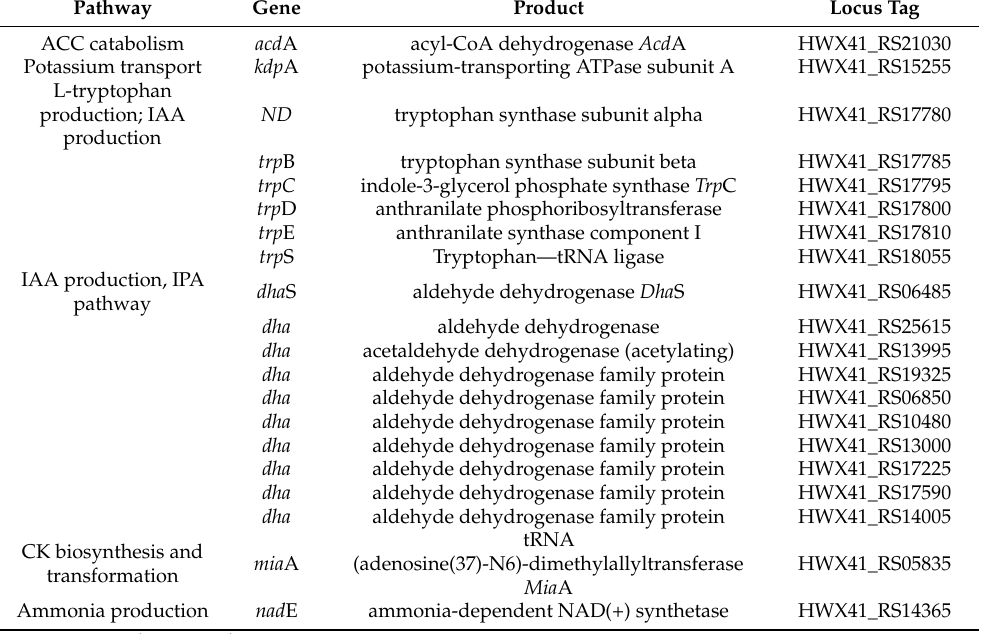
Table 5. Genes involved in the modulation of plant